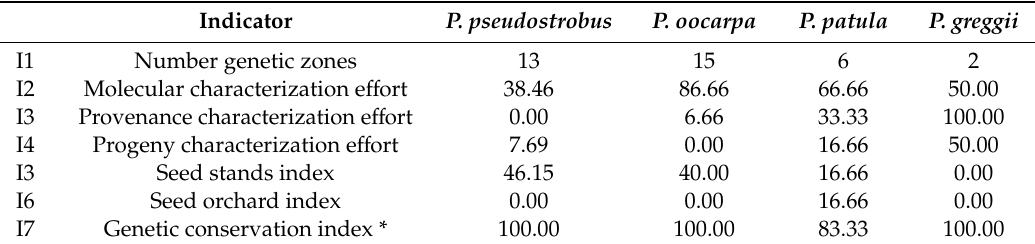
Table 3. Indicators for the target species.